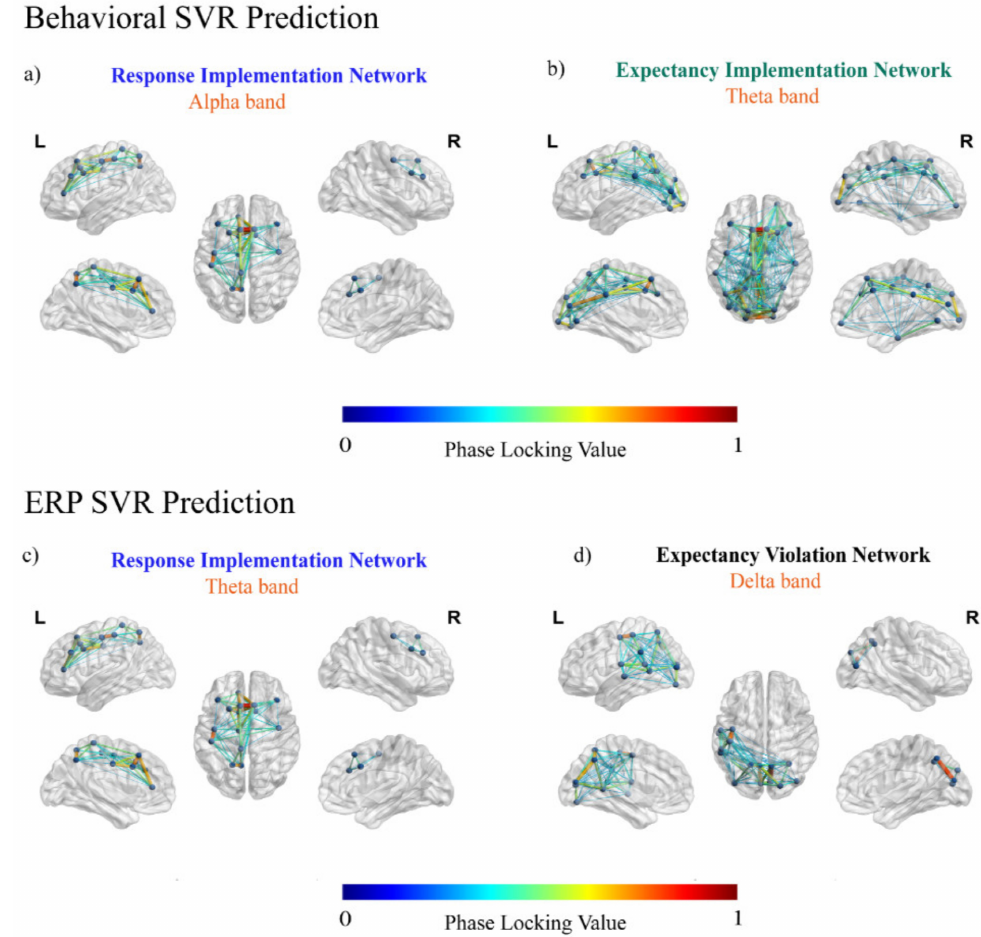
Figure 5. Resting state functional connectivity (RS-FC) predicting task-dependent behavioral and event related potential (ERP) effects. The present figure shows the mean connectivity patterns (averaged across the subjects) for the target RS networks. ( a ) in the upper row represents the connectivity pattern, in the alpha band, of the response-implementation network predicting, using a support vector regression (SVR), the behavioral performance (delta global reaction time (RT) and inverse efficiency score (IES)). ( b ) represents the resting network activity of the expectancy- implementation network in the theta band, predicting delta global accuracy. The lower row represents the RS-FC predicting the task-dependent ERP modulations. Specifically, functional connectivity at rest in the response-implementation network predicted the response-implementation ERP effects (P3 amplitude increase) in the theta frequency band ( c ). Similarly, the RS-FC of the expectancy- violation network in the delta band predicted the ERP effect (omission detection potential (ODP) increase) elicited during the expectancy violation in the task ( d ). To avoid overloading of images, we report only the main results here. Additional figures are provided in the Supplementary